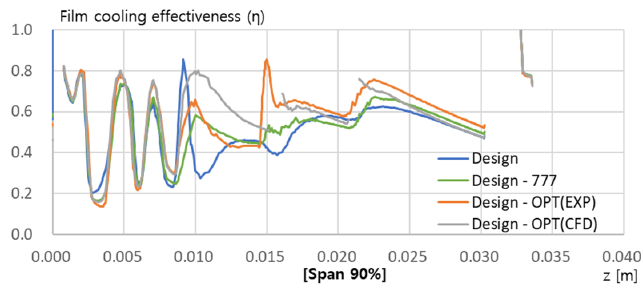
Figure 15. Film cooling effectiveness for the three types of the fan-shaped hole.